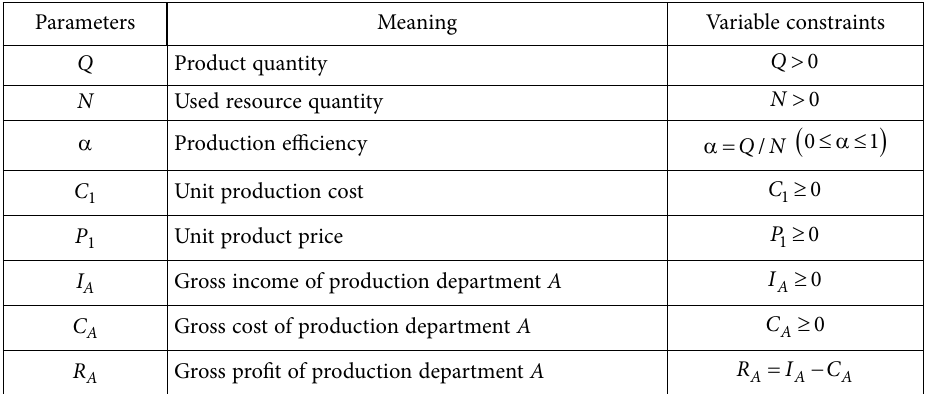
Table 1. Production department-related parameters Parameters